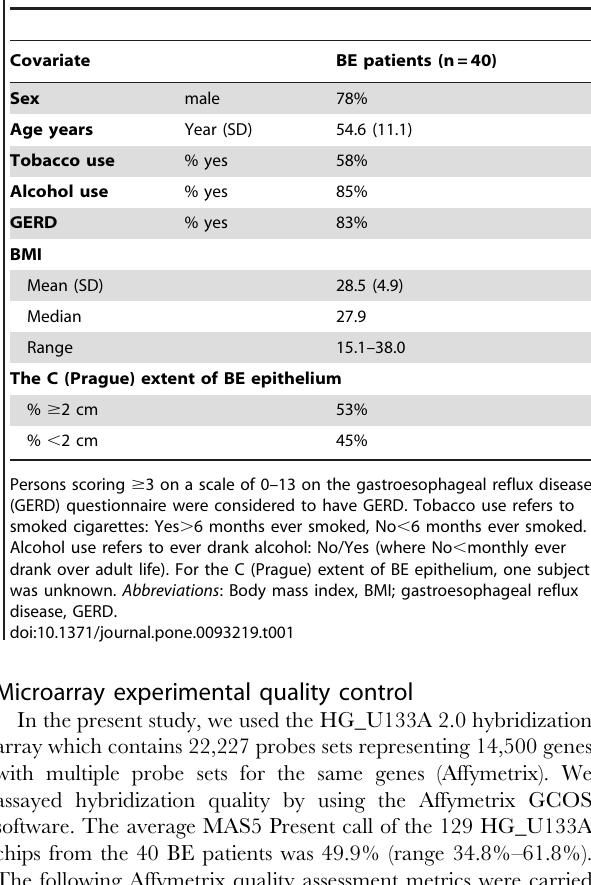
Table 1. Characteristics of study